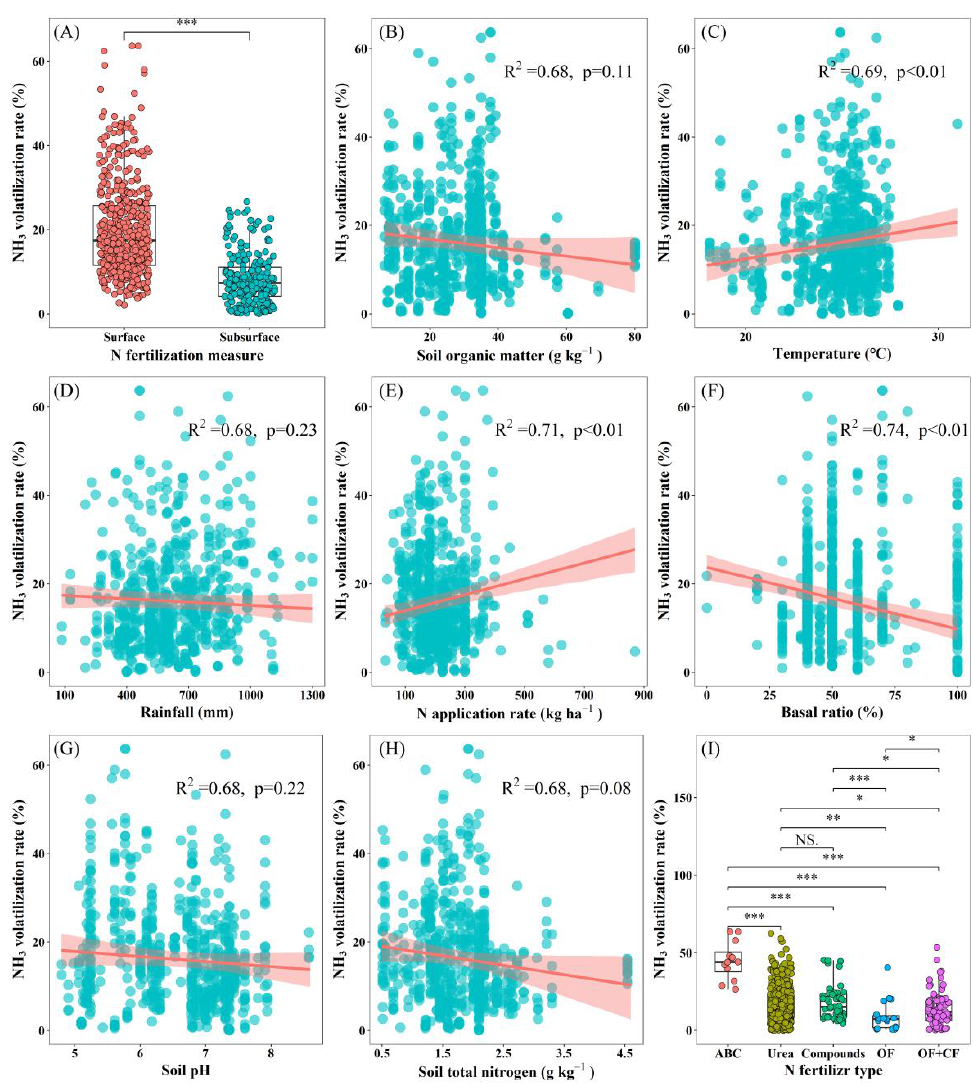
Figure 2. Influencing factors of NH 3 losses from rice production systems across China. The asterisks (*) in ( A ) and ( I ) show significant differences between groups, with *, **, and *** indicating signif- cance levels at 0.05, 0.01, and 0.001, respectively. The solid line and surrounding shaded areas in ( B – H ) represent the predicted value and 95% confidence interval of the linear mixed effect model, re- spectively.